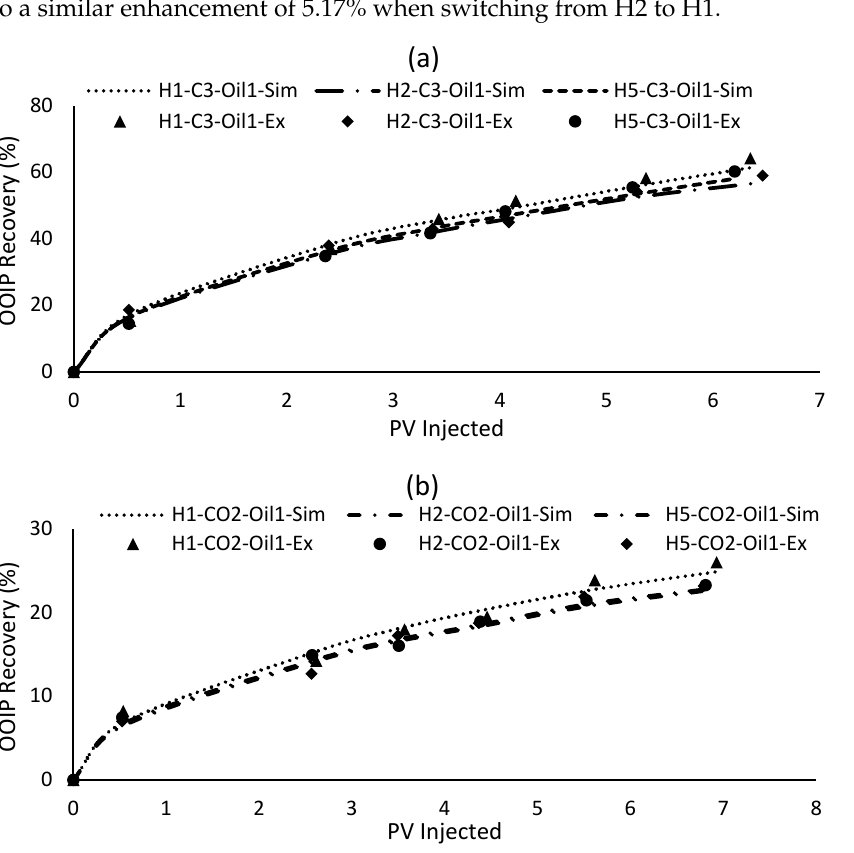
Figure 18. The effect of fracture position on the recovery factors in conventional VAPEX and patterns H1, H2, and H5 using propane ( a ) and carbon dioxide ( b ).